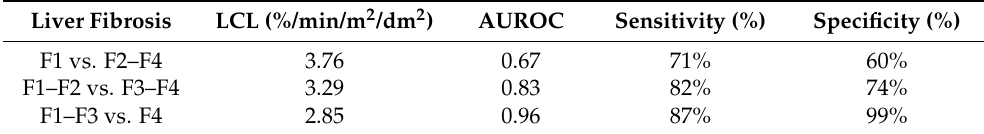
Table 4. Liver clearance threshold values defining different liver fibrosis stages.